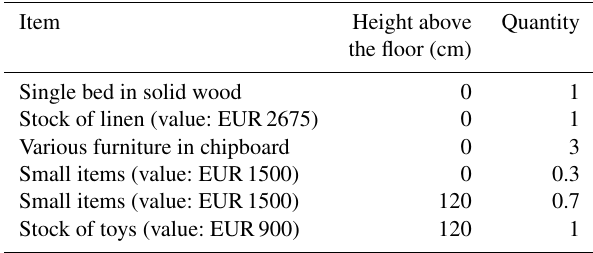
Table 2. Pieces of furniture contained in Bedroom 1 of the single- storey house (see Fig.